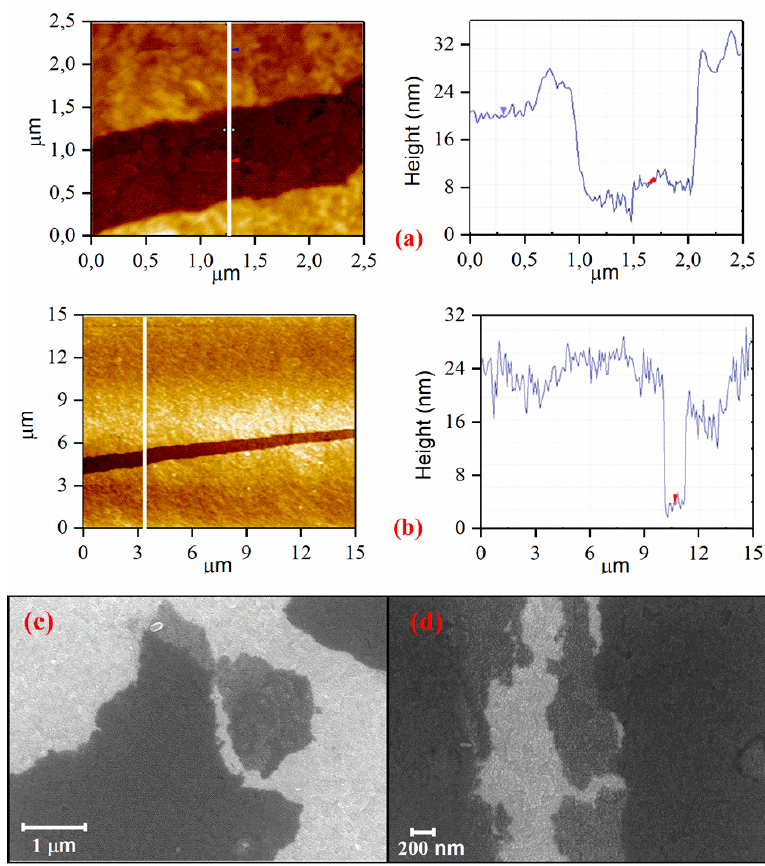
Figure 3. Atomic force microscopy (AFM) images and corresponding cross-sections ( a , b ), and SEM ( c , d ) images of hybrid rGO–PbS LB film.